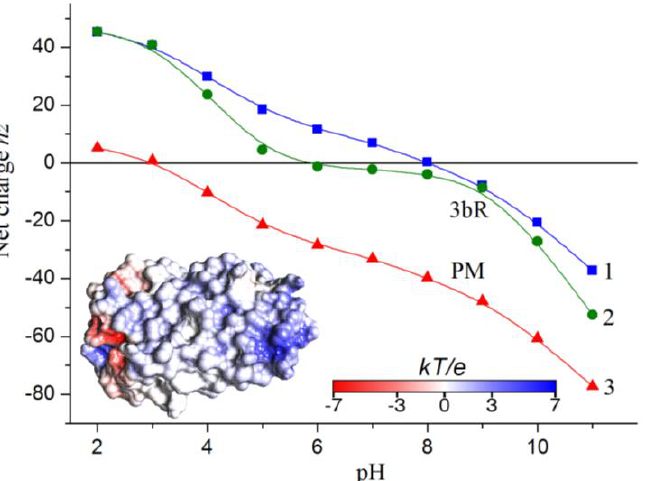
Figure 1. pH-dependences of the net charge nz of the polypeptide chain of bacteriorhodopsin trimer (3bR) in folded (curve 1) and unfolded (curve 2) conformation, and nz of purple membrane (PM, curve 3). Insert : Molecular model of single bR macromolecule horizontally oriented with the cytoplasmic side on the left. The colors correspond to the sign (red — negative and blue — positive) and the value of the electrostatic potential on the intramembrane surface of the bR monomer in the range of – 7 kT / e to +7 kT / e , where e — the elementary charge, k — Boltzmann constant, and T — absolute temperature; kT / e = 25.26 mV at 20 °C.